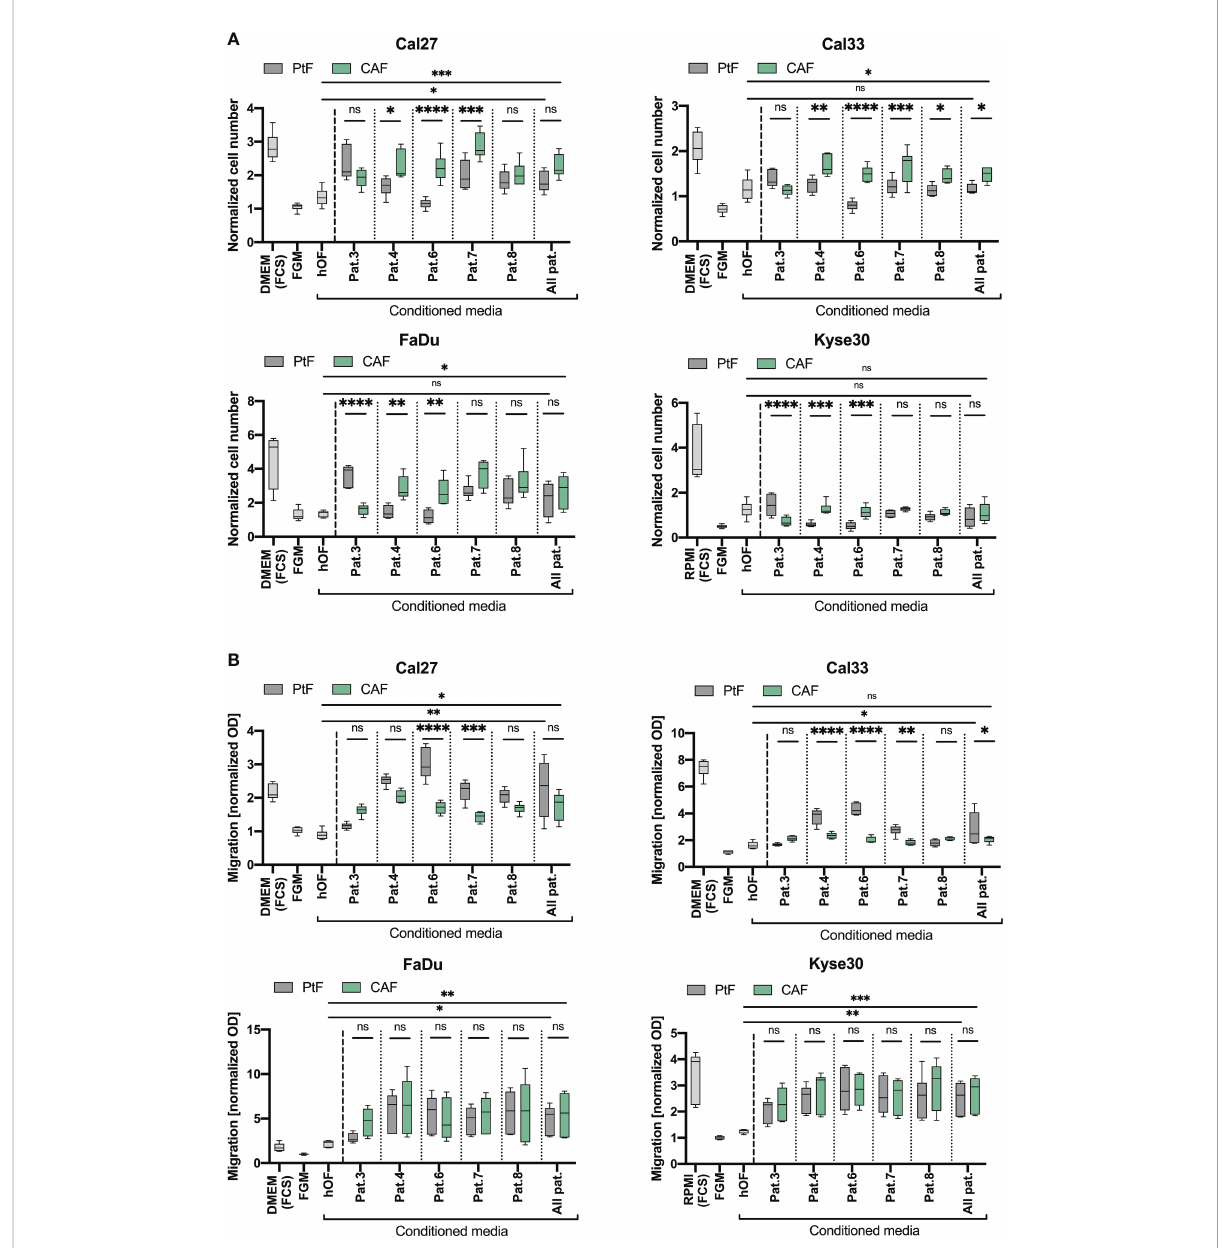
FIGURE 4 Effect of PtFs and CAFs on carcinoma cell line proliferation and migration. (A) Cal27, Cal33, FaDu and Kyse30 cell lines were cultured for 72 hours in human oral fi broblast (oHF)-, PtF-, or CAF-conditioned supernatant. Cell numbers are normalized to D0 and to DMEM/RPMI w/o FCS culture condition. Mean ± SD normalized cell numbers of controls (cell cultured in DMEM/RPMI with FCS, or in FGM) and treatment groups (cells cultured with hOF/PtF/CAF-conditioned FGM of individual patients) of n=3 independent experiments are shown. (B) Migration of Cal27, Cal33, FaDu and Kyse30 cells was measured using a Boyden chamber with FGM, DMEM/RPMI with FBS, and conditioned hOF/PtF/CAF- conditioned supernatant served as attractants in the lower chamber. Normalized OD values are plotted from n=3 individual experiments. P-values: ns > 0.05; * ≤ 0.05; ** ≤ 0.01; *** ≤ 0.001; **** ≤